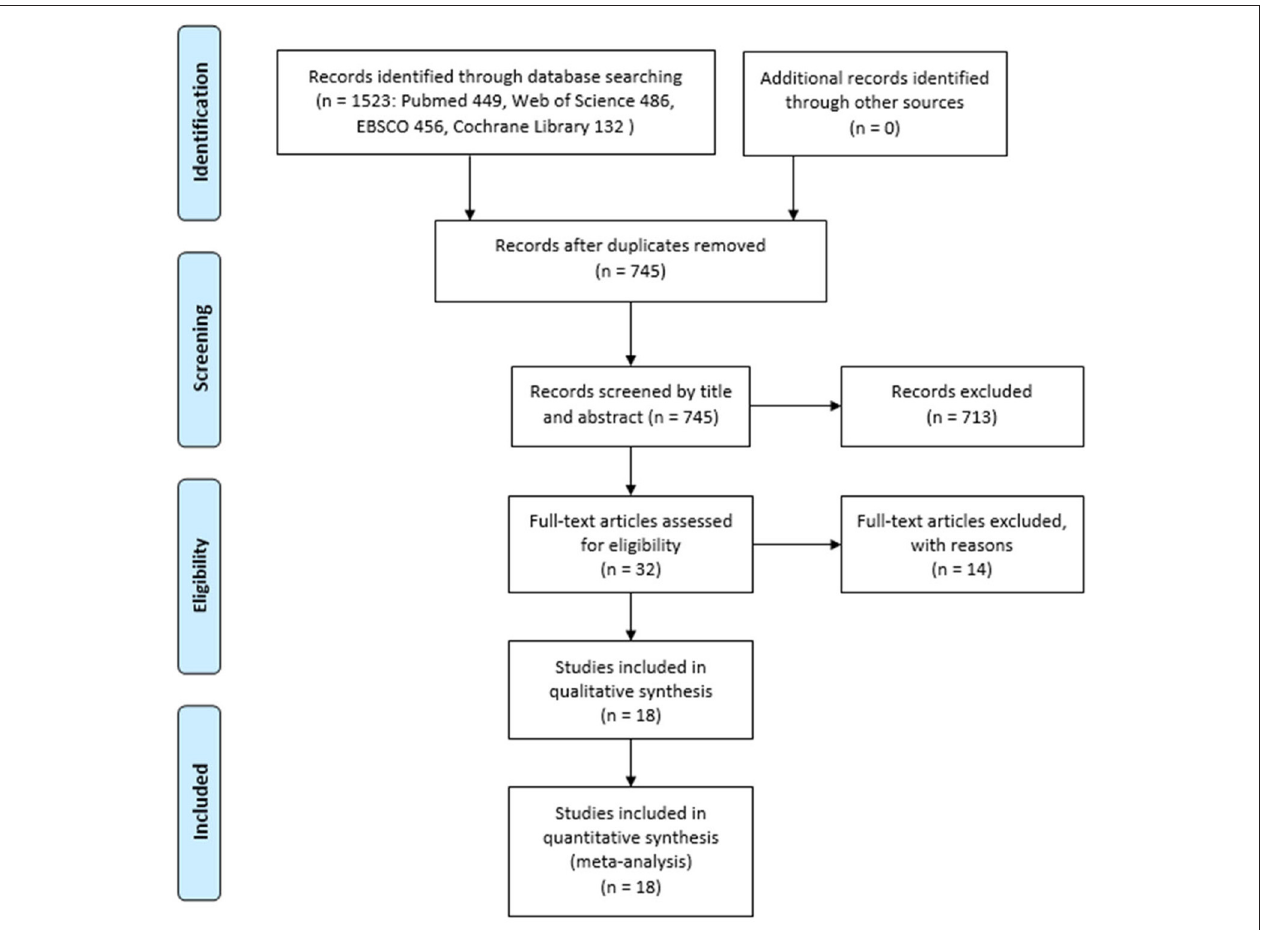
FIGURE 1 | The flowchart of search